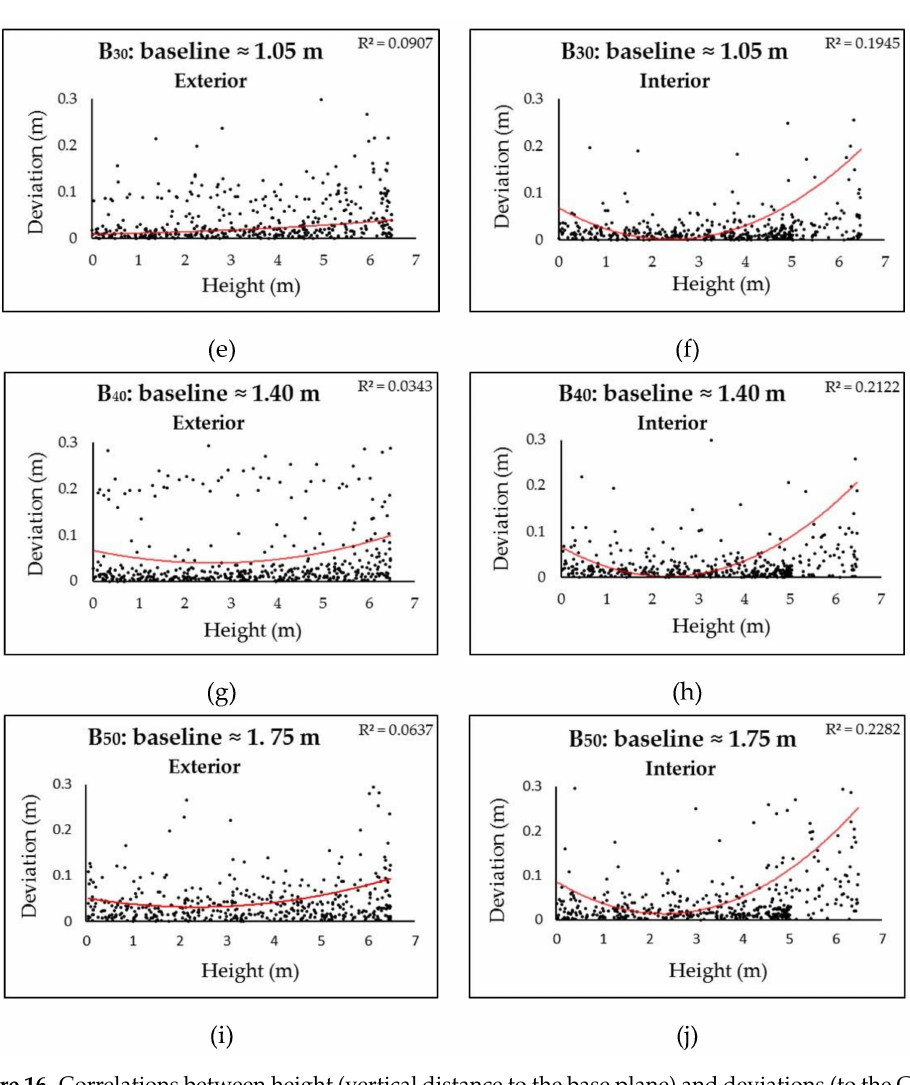
Figure 16. Correlations between height (vertical distance to the base plane) and deviations (to the GTM) in the Pavilion dataset with variable baselines. Two-polynomial trend lines (in red) with correlation coefficient (R 2 ) are given. ( a ) ( c ) ( e ) ( g ) ( i ) represent exterior walls; and ( b ) ( d ) ( f ) ( h ) ( j ) represent interior walls and vaults.